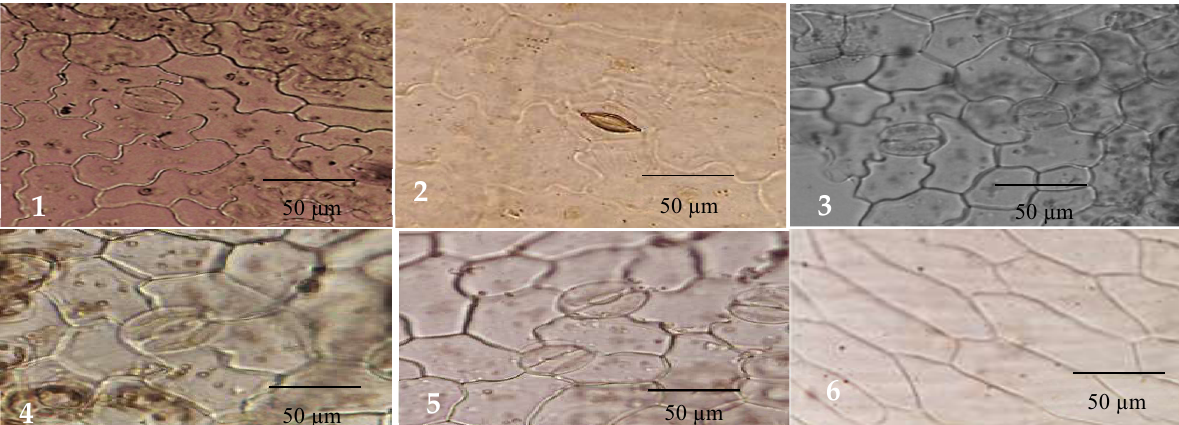
Figure 4. SEM micrographs of stomata level and ornamentation in Cichorium : A : C. intybus var. inty- bus ; B : C. intybus var. foliosum ; C : C. endivia var. endivia ; D : C. endivia var. crispum ; E : C. endivia subsp. pumilum .